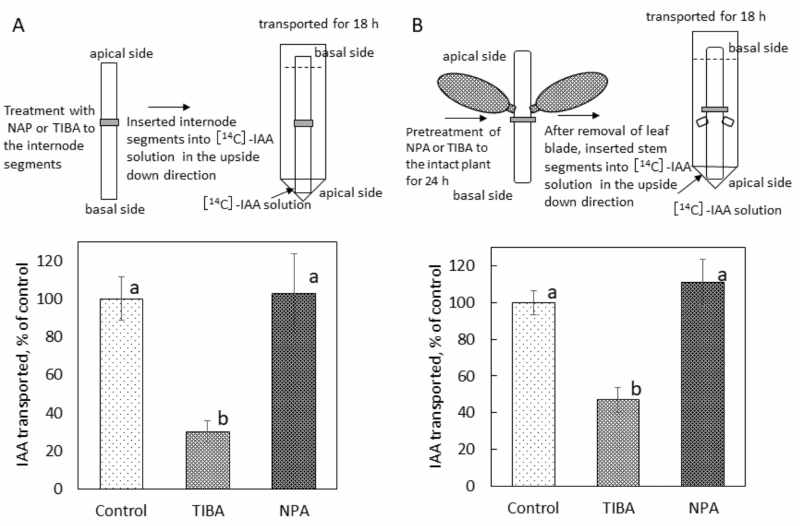
Figure 4. Effect of NPA and TIBA on polar auxin transport in stem segments of B. calycinum . ( A ): Internode segments (25 mm in length) were prepared, and then, lanolin with or without NPA (0.4%, w/w in lanolin) or TIBA (0.4%, w/w in lanolin) was applied to the middle of the internode. ( B ) : Internode segments (40 mm in length) were prepared from intact stems pretreated with TIBA or NPA for 24 h prior to the experiment. Internode segments treated only with lanolin served as control segments. After removing leaf blade, the stem segments were placed into vials facing down the apical side. Polar auxin transport was assessed by radioactivity of [ 14 C]-IAA transported from the apical to the basal end of the stem segments for 18 h. The results were expressed as percentages of control values. Vertical lines represent SE of the mean ( n = 3). Different letters indicate statistical difference in Student’s t -test at p < 0.05 after